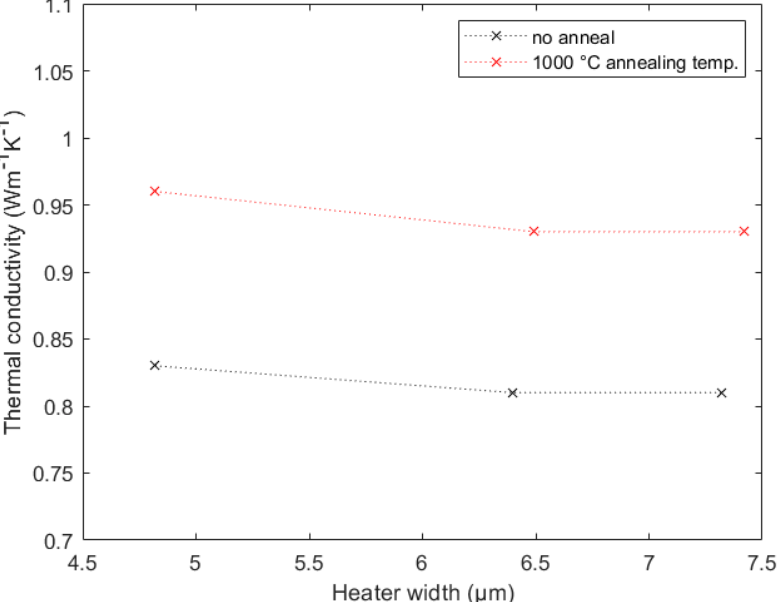
Figure 12. Measurement results for the 115 nm thin Al 2 O 3 film and the 102.7 nm thin Al 2 O 3 film with annealing at 1000 °C.